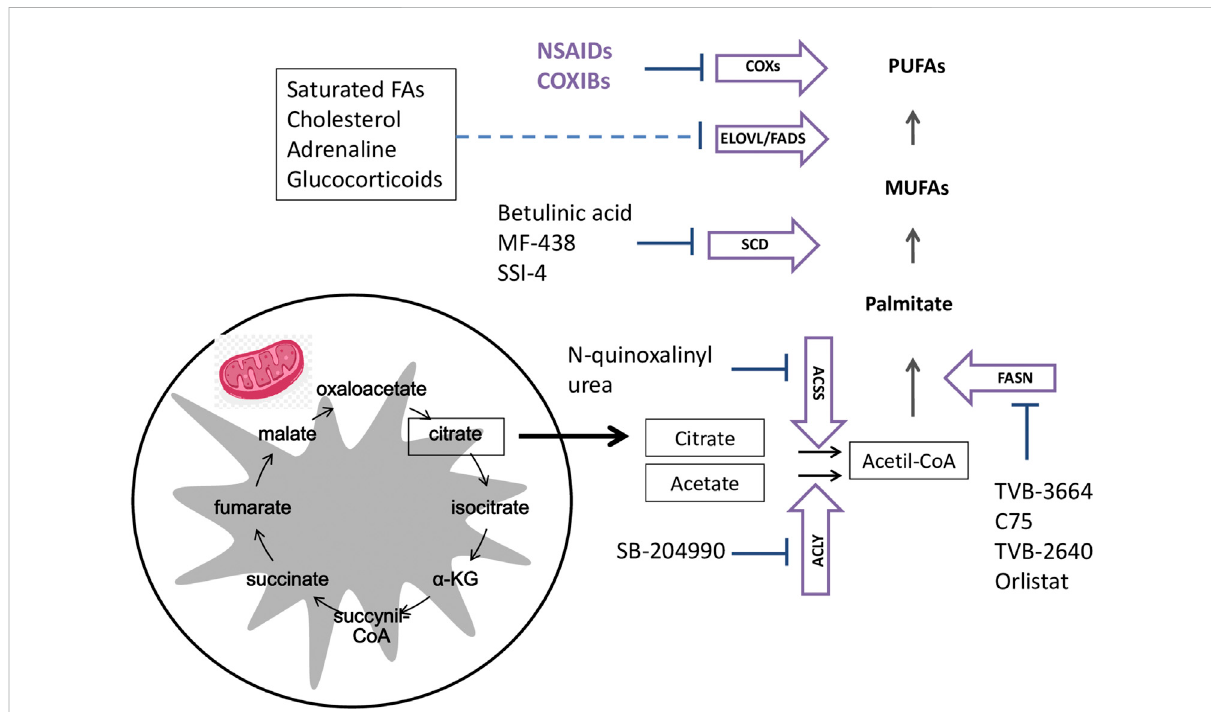
FIGURE 3 Targetingenzymesinvolvedinfattyacidoxidationorbioactivelipidsynthesis:Cancercellsobtainfattyacids(FAs)from denovo lipogenesisand exogenous uptake. FAs and their synthetic products can be subsequently stored as lipid droplets or used for acetyl-CoA production through β - oxidation.Palmitateisthemainproductof denovolipogenesis anditisgeneratedfromcitrateoracetatethroughtheenzymaticactivitiesofACSSor ACLY, respectively to give rise to acetyl-CoA. Acetil-CoA can be metabolized by FASN to Palmitate (16:0) that will be metabolized by SCD1 to MUFAand,subsequentlydesaturatedandelongatedthroughtheactivityofELOVLsandFADstoproduceadiversegroupofPUFAs.Finally,PUFAsare substrate of COXs enzymes that oxygenate these FAs to bioactive lipids with a differential activity in tumor initiation and progression. The enzymes involved in FA oxidation, as well as those able to give rise to bioactive lipids can be a therapeutic target to hamper tumor progression. Abbreviations: COXs: cyclooxygenases; ELOVLs: FA elongases; FADSs: FA desaturases; ACLY: ATP-citrate lyase; ACSS2: acetyl-CoA carboxylases. FASN: FA synthase; SCD1: stearoyl-CoA desaturase; MUFA: monounsaturated fatty acids; PUFAs: polyunsaturated fatty acids; α -KG, α